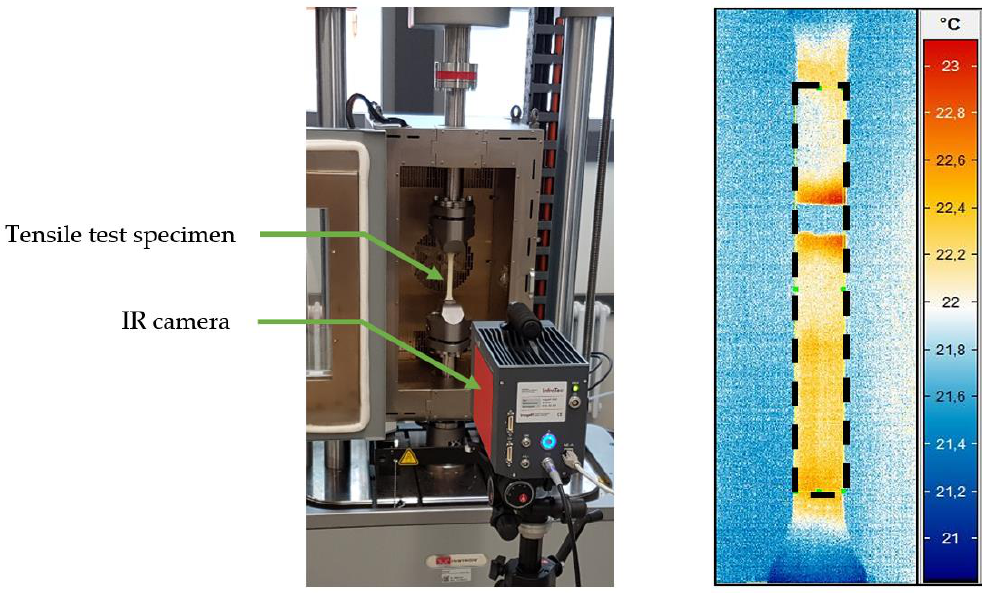
Figure 6. Experimental setup with thermographic measurement for detection of specimen heating.